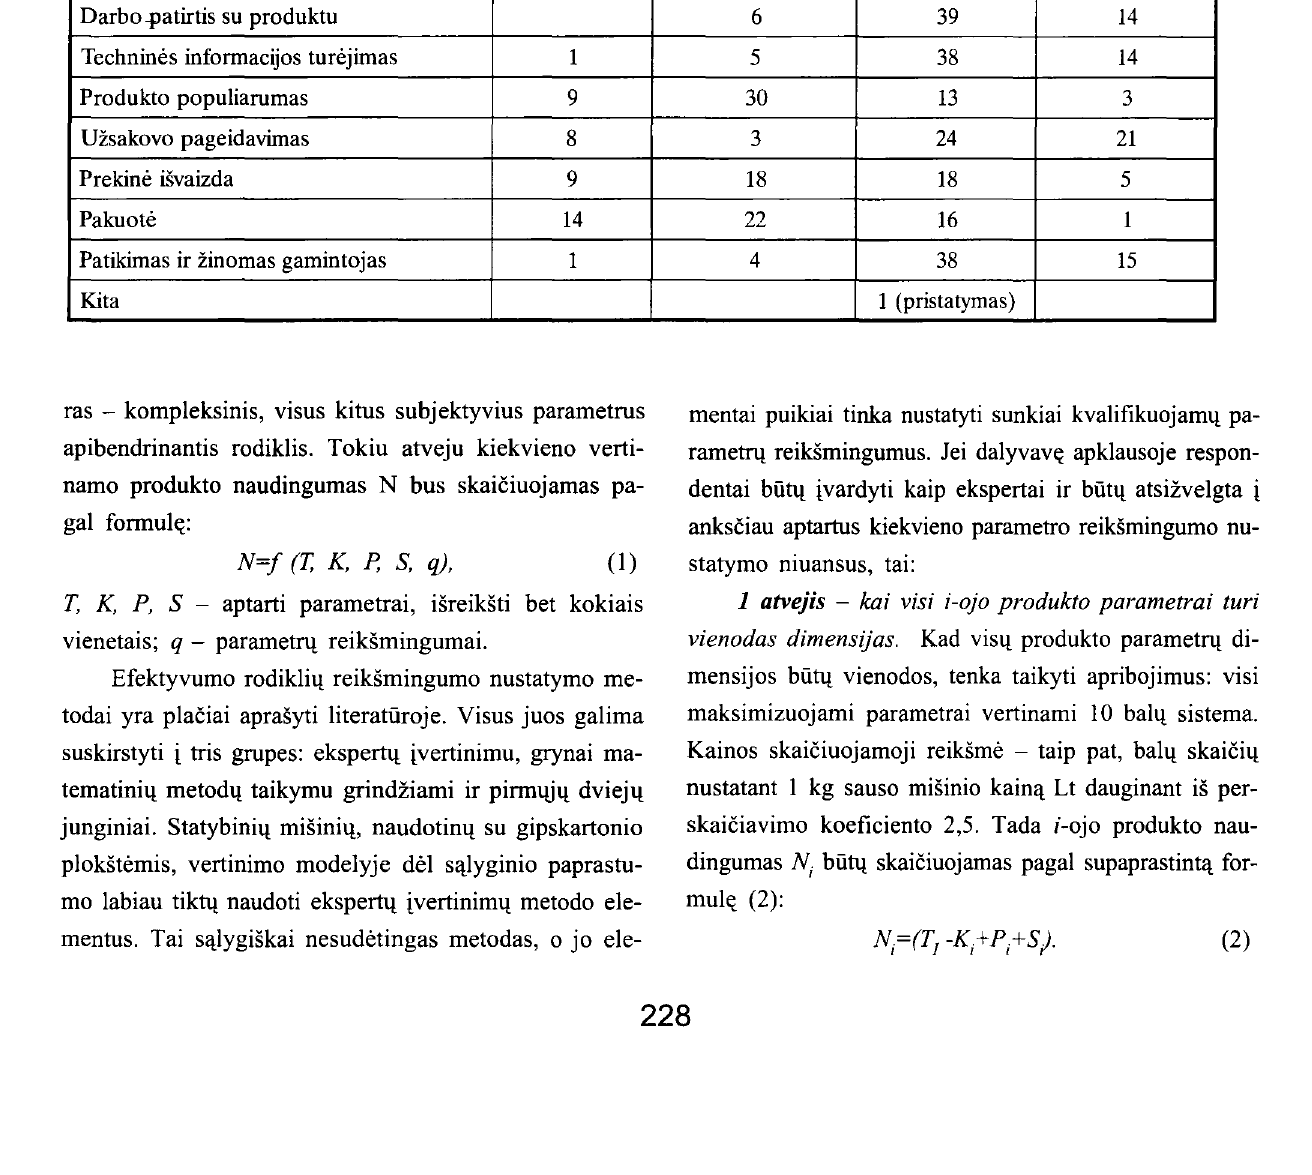
Table 4. The results of answers about importance of subjective indexes Subjektyviis parametrai